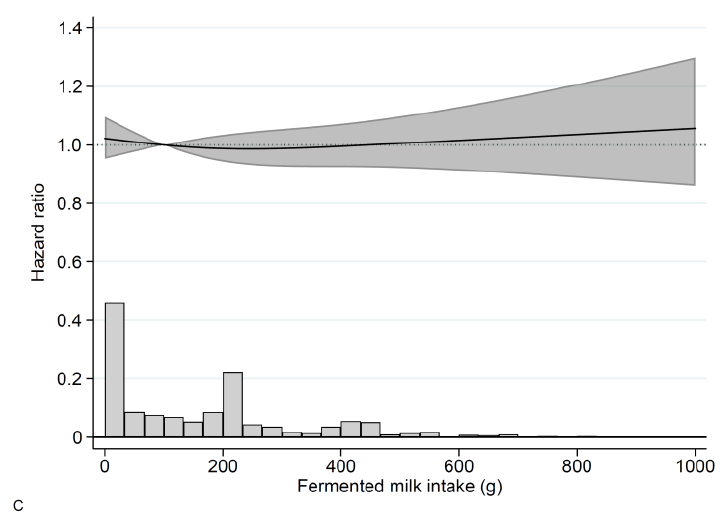
Figure 2. Hazard ratios (solid line) and 95% confidence intervals (gray shaded area) for fermented milk consumption and ( A ) total stroke, ( B ) cerebral infarction, and ( C ) hemorrhagic stroke in The Swedish Mammography Cohort and the Cohort of Swedish Men. A total of 100 g/day was used as reference. The distribution of milk intake is shown in the histogram. Time at risk was accrued between 1 January 1998 and 31 December 2019, with time-updated information in 2008/2009. Covariates included in the model were sex (through stratification), age, educational level, smoking status, physical activity, body mass index, history of hypertension, hypercholesterolemia, diabetes mellitus, coronary heart disease, Charlson’s weighted comorbidity index, vitamin- and mineral supplement use, intakes of total energy, fruit and vegetables, processed meat, soft drinks and juices, alcohol, coffee, milk, total fat, and saturated fat.